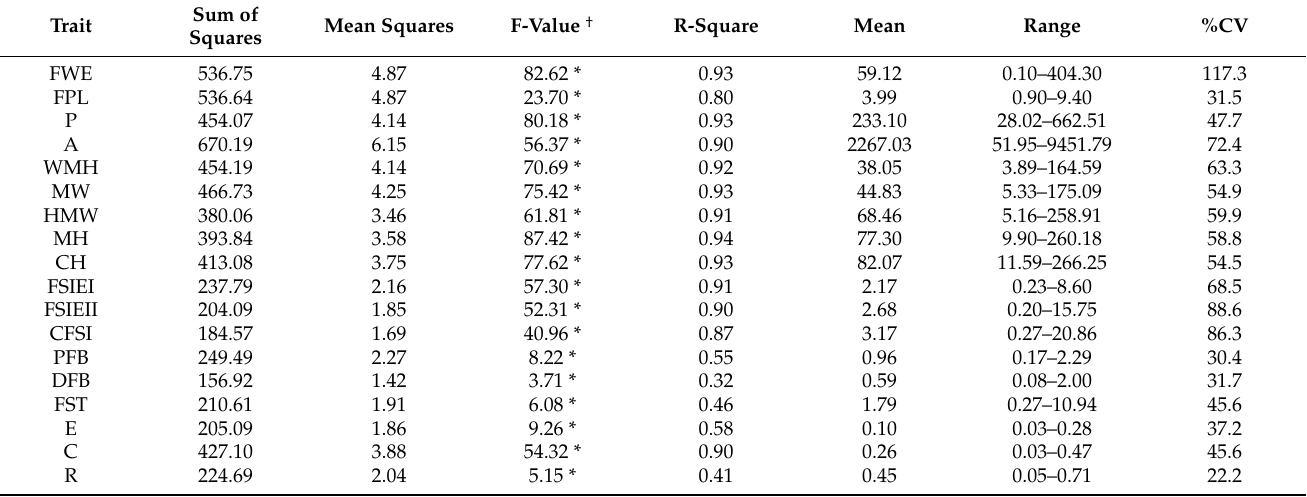
Table 1. Analysis of variance (sum of squares, mean squares, F-value, and R-square), mean, range, and coefficient of variation for conventional (FWE and FPL) and Tomato Analyzer descriptors in 139 C. annuum accessions. See Table S5 for trait